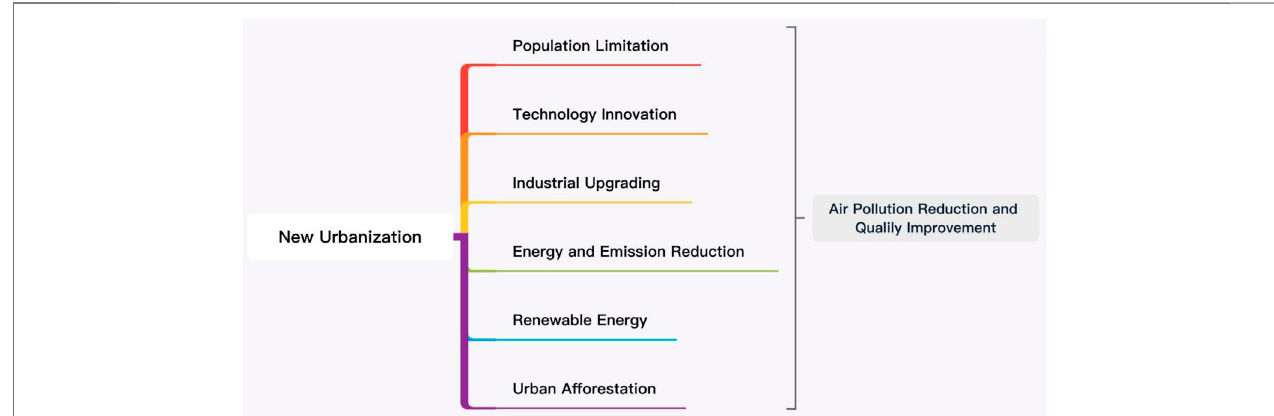
FIGURE 4 | In fl uencing